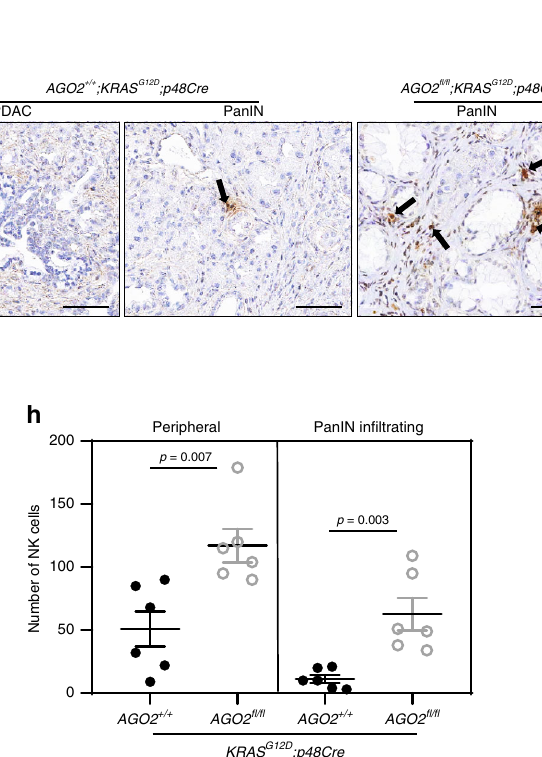
patterns with RAS (PanIN PCC = 0.5; PDAC PCC = 0.7). RAS staining could also be detected in the PanIN lesions of AGO2 fl / fl ; Kras G12D ;p48Cre mice (Supplementary Fig. 8a). Localization of AGO2 to the plasma membrane was independently con fi rmed by analyzing co-localization with the membrane marker, E-cadherin (PCC = 0.43; Supplementary Fig. 8b). Furthermore, in pancreatic tissue obtained from normal mice treated with caerulein